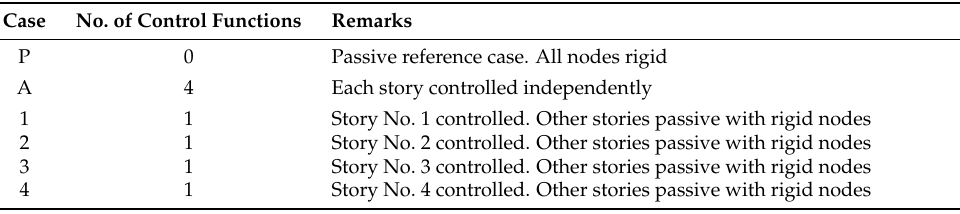
Table 2. Six control cases used to compute, assess, and compare the responses. The two nodes on each story were controlled pairwise and synchronously.